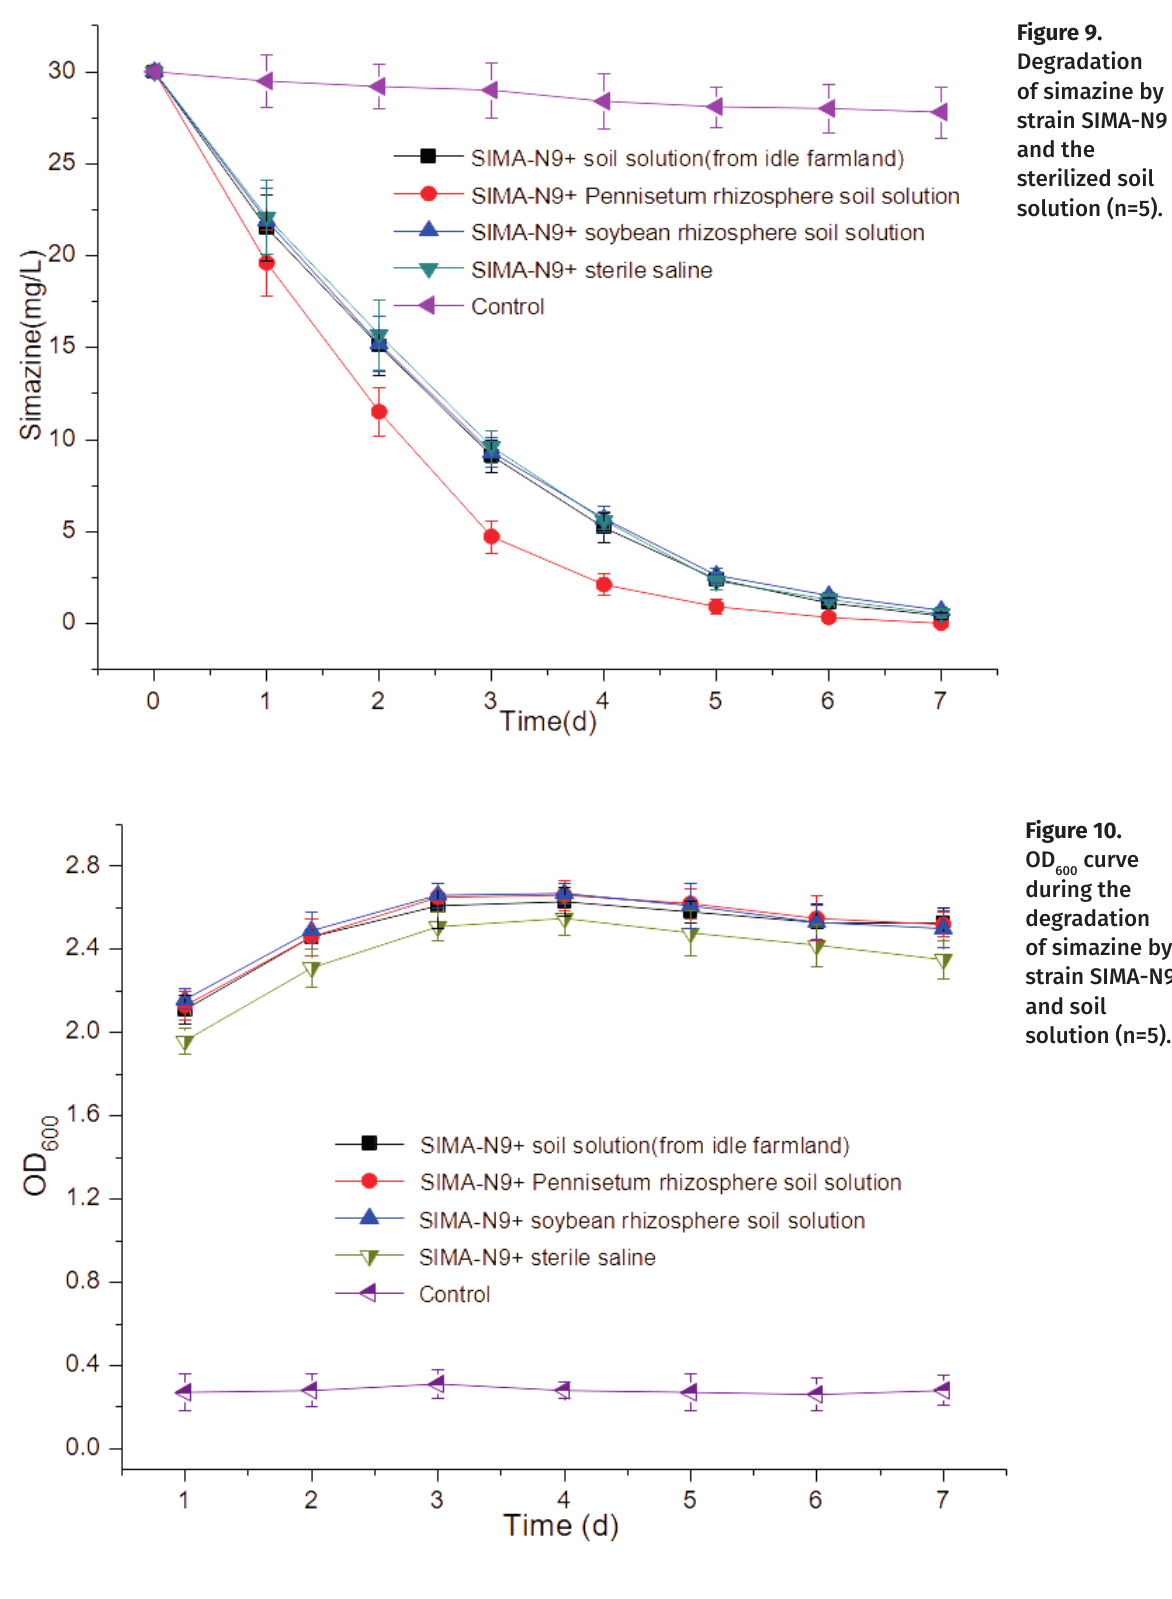
Figure 10. OD curve 600 during the degradation of simazine by strain SIMA-N9 and soil solution